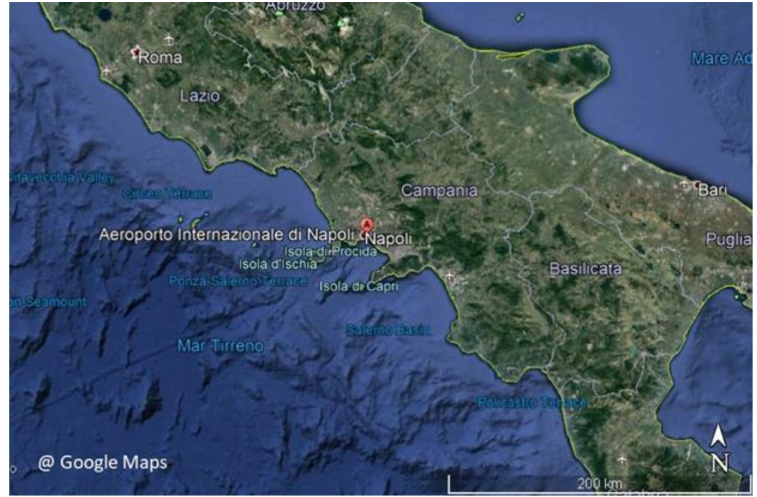
Figure 1. Geographical Location of Napoli Capodichino Airport in Southern Italy. Impacts over European airports differ according to the geographical position, but risks are larger on those areas where an increase of air traffic is expected, such as southern Europe. Climate extremes can hit the European aviation sector in many manners. Specific impacts for the airport of Naples can be summarized as